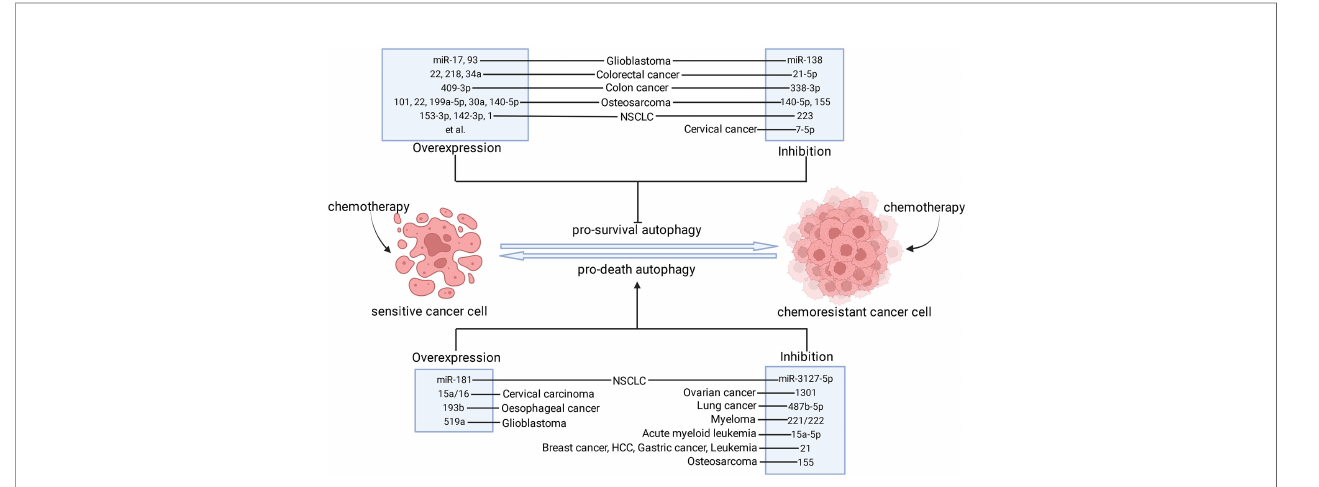
FIGURE 2 | The strategies of modulating miRNAs to combat chemoresistance through autophagy. After chemotherapy is applied, sensitive cancer cells mainly undergo apoptotic cell death process whereas chemoresistant cancer cells fail to respond to chemotherapeutics. The pro-survival autophagy contributes to the development of chemoresistance. However, pro-death autophagy can be used as an alternative cell death mechanism in apoptosis-inactive cancer cells to re- sensitize them. Based on these facts, inhibition of pro-survival autophagy and induction of pro-death autophagy may result in chemoresistance reversal, which can be done by overexpression or inhibition of these miRNAs in different types of cancer. ⊥ indicates an inhibitory effect and ! indicates a promoting